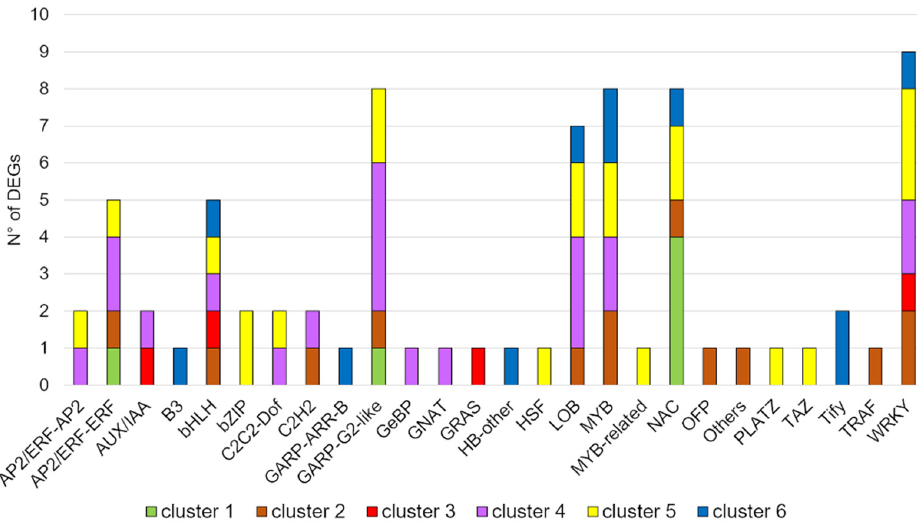
Figure 5. Comparison between transcription factors (TFs) in the six clusters. Cluster 1, DEGs down-regulated by nitrate provision and NO-dependent; cluster 2, DEGs down-regulated by nitrate and NO-independent; cluster 3, DEGs down-regulated by nitrate and NO-modulated; cluster 4, DEGs up-regulated by nitrate provision and NO-dependent; cluster 5, genes up-regulated by nitrate provision and NO-independent; cluster 6, DEGs up-regulated by nitrate and NO-modulated. The number of genes coding for transcription factors were detected using the iTAK database.